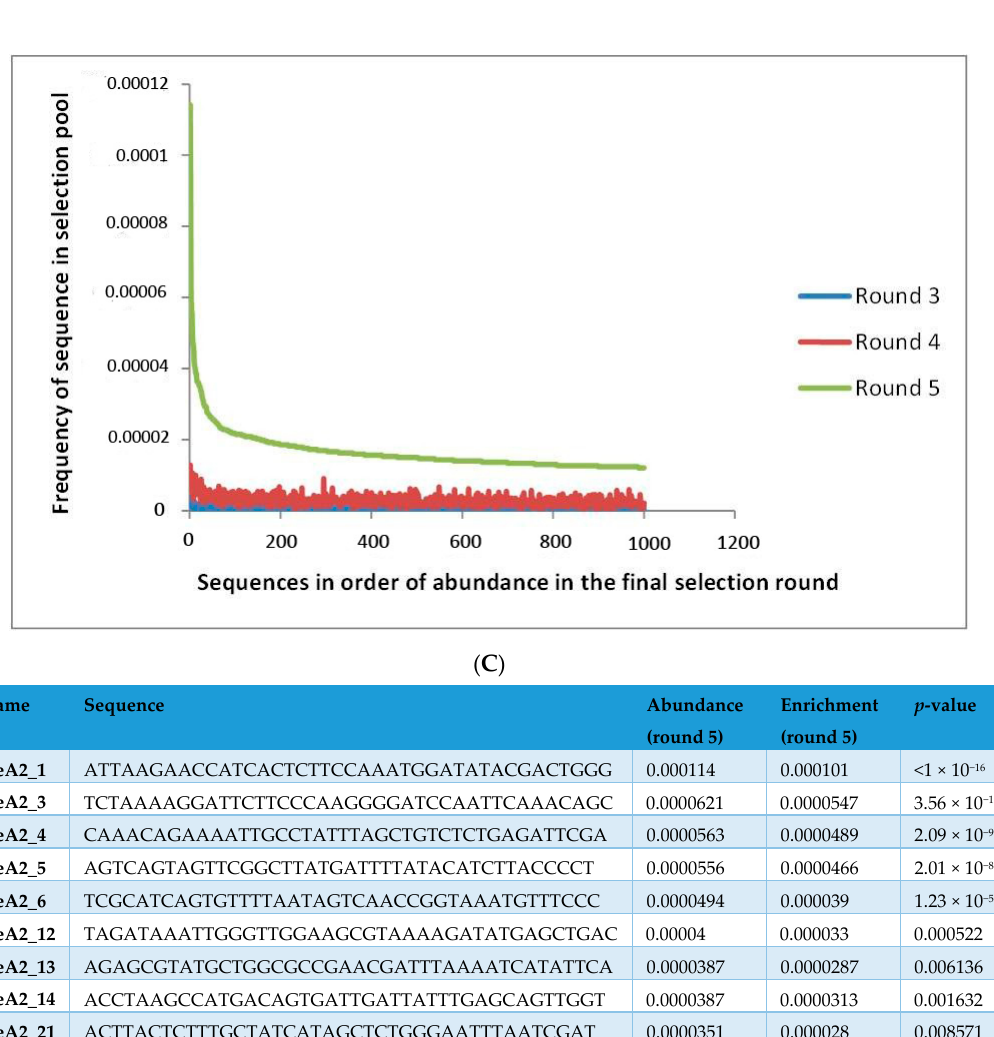
aptamer pools decreased with the progress of the selection (Figure